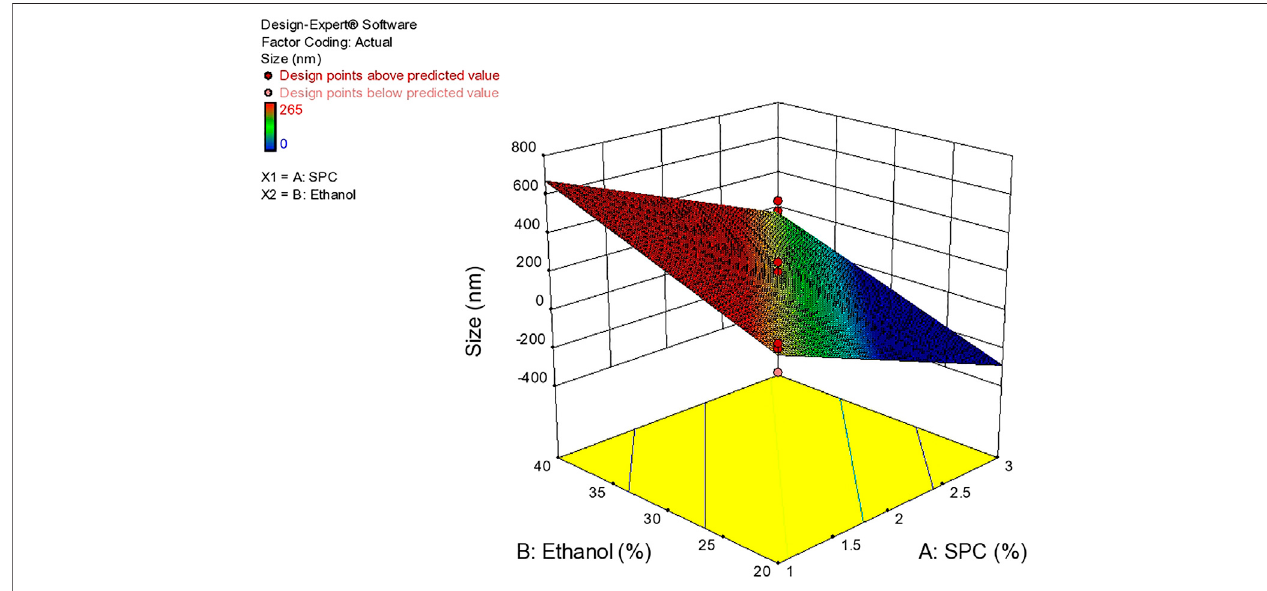
FIGURE 4 | Response surface plots showing effect of lipid and ethanol on size.